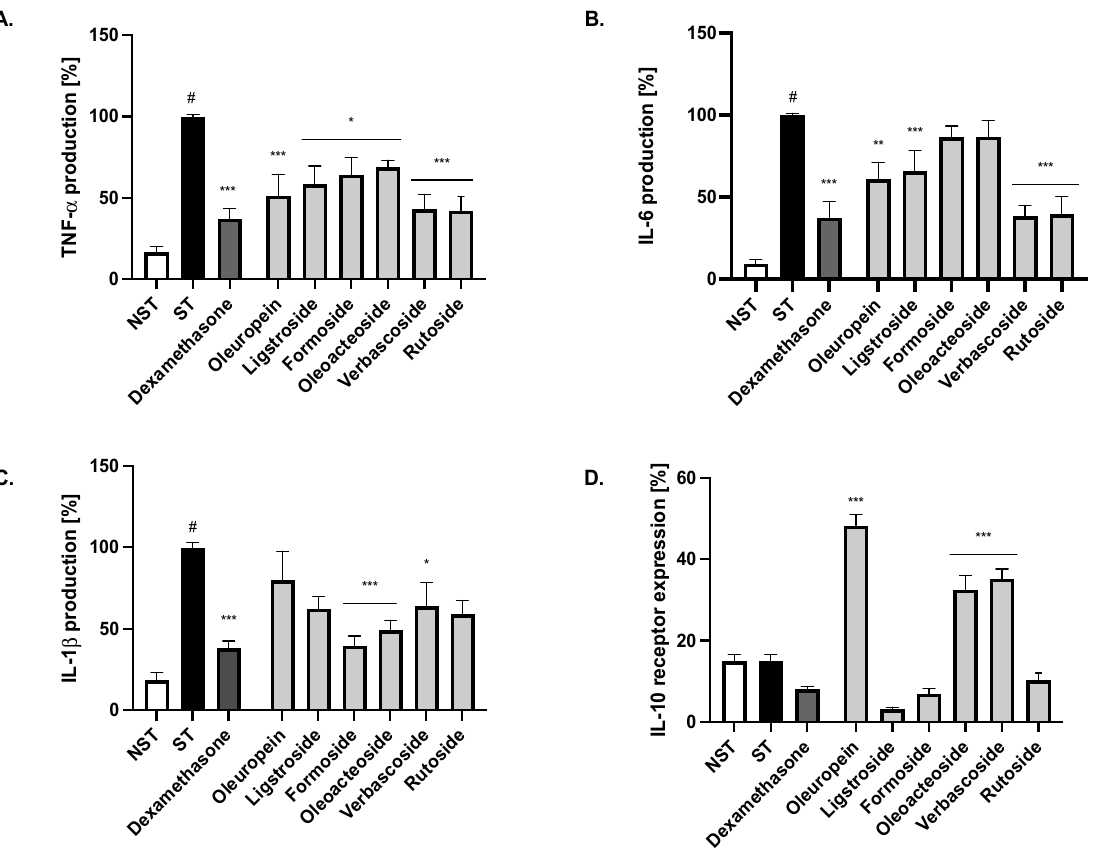
Figure 6. The influence of compounds on ( A ) TNF- α , ( B ) IL-6, ( C ) IL1- β secretion and ( D ) IL-10 receptor expression by LPS-stimulated monocytes/macrophages. Non-stimulated cells (NST), LPS- stimulated (ST) monocytes/macrophages and LPS-stimulated monocytes/macrophages treated with 20 μ M of selected compounds. Dexamethasone (20 μ M) was used as positive control. Data are expressed as mean ± SEM (three separate experiments performed on monocytes/macrophages isolated from independent donors). Statistical significance: * p < 0.05, ** p < 0.01, *** p < 0.001 versus stimulated control, # statistically significant ( p < 0.001) versus non-stimulated control.